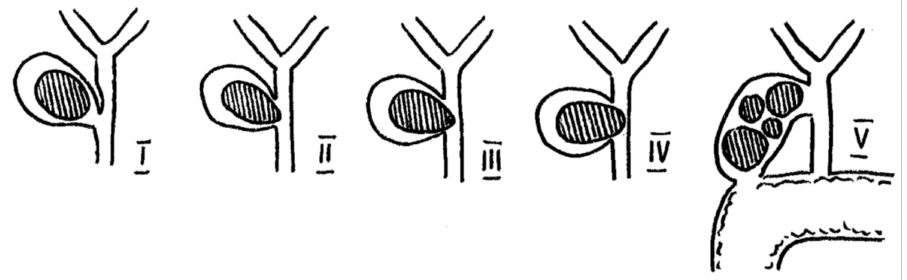
Figure 1. Anatomical sketch of Mirizzi Syndrome according to Csendes and Beltr á n